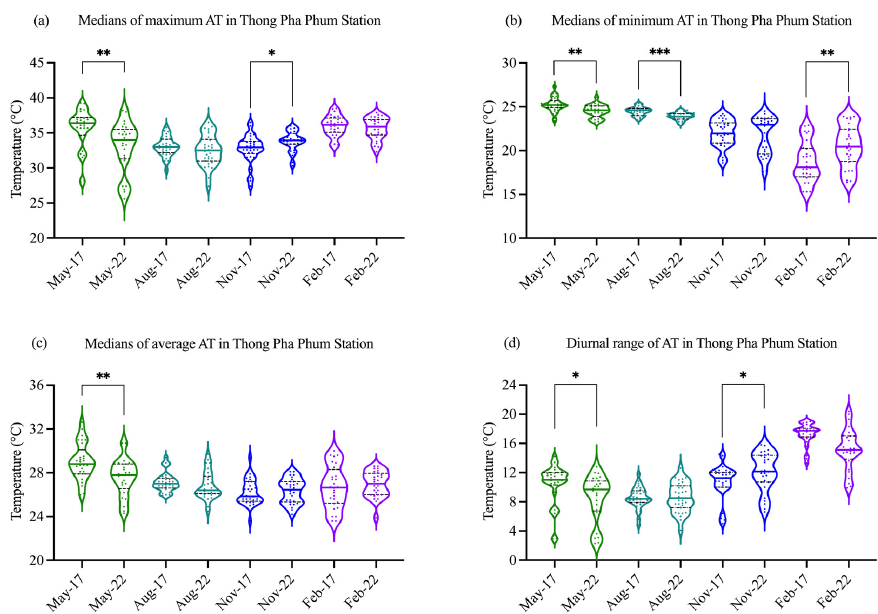
Figure 3. The medians of maximum ( a ), minimum ( b ), average ( c ), and diurnal range ( d ) of AT in Thong Pha Phum station during the study periods of dry season (November and February) and wet season (May and August) in 2017 and 2022. For each violin plot, the bold horizontal line in the center of the box represents the median, and the dash lines at the bottom and top of the box represent the first and third quartiles, respectively. *, **, and *** indicate significance at p < 0.05, p < 0.01, and p < 0.001, respectively, as determined by independent samples t-test.